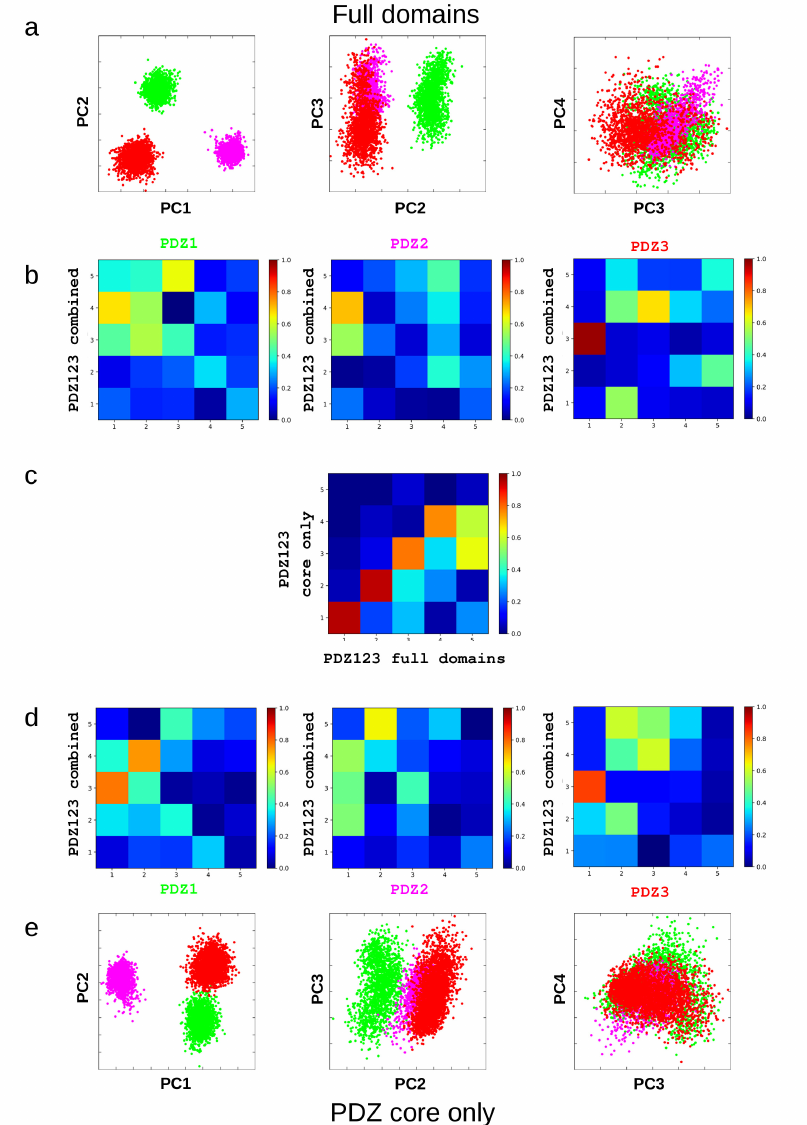
Figure 6. Comparison of dynamic structural ensembles of the three PDZ domains of PSD-95. ( a ) distribution of the PDZ1 (green), PDZ2 (magenta) and PDZ3 (red) ensembles along the PCs 1–2, 2–3 and 3–4 (from left to right, respectively) as well as ( b ) the overlap of PCs calculated for individual ensembles with the combined one. ( d , e ) the same as ( a , b ) but only using the residues common to all PDZ domains (“PDZ core”). ( c ) comparison of the results obtained with the two analyses showing the overlap for the first 5